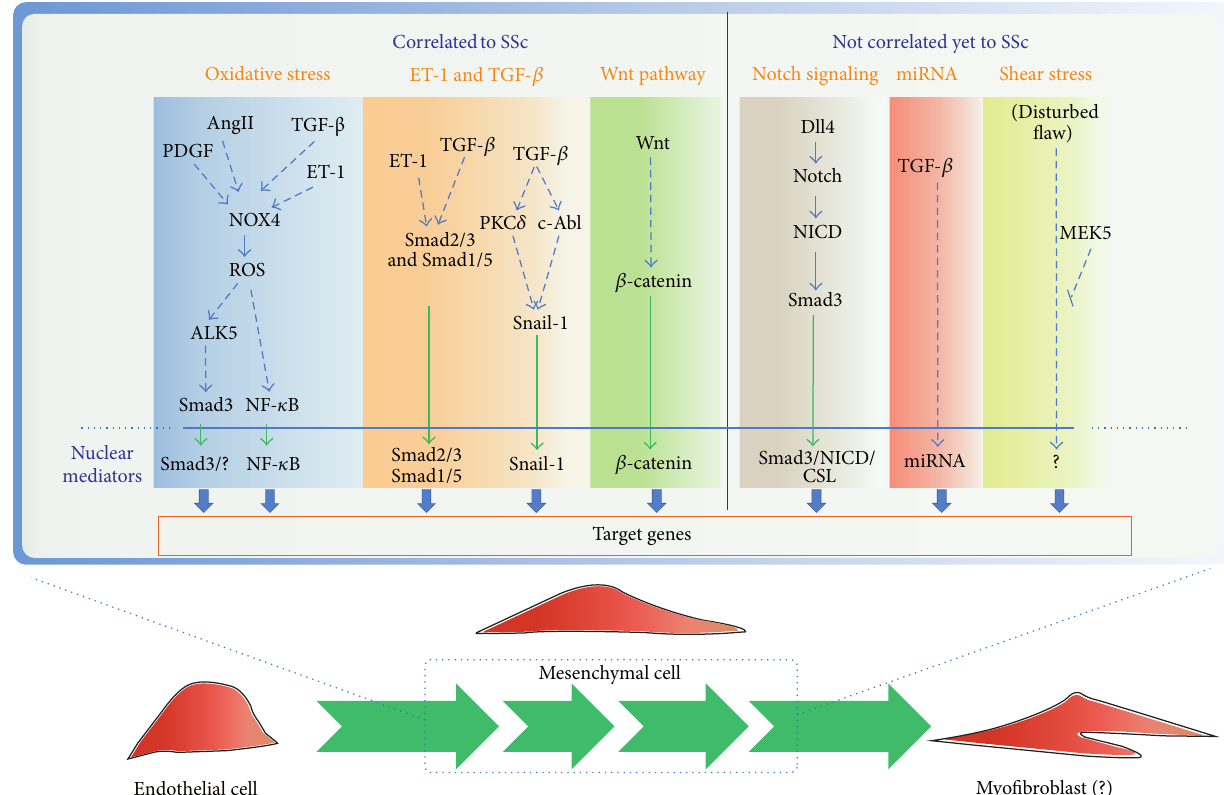
Figure 2: Pathways involved in the EndoMT. The scheme summarized the putative pathways involved in the EndoMT highlighting which are already correlated or not with SSc. The activation of specific nuclear mediator leads to activation of target genes that are correlated with the increase of mesenchymal markers (such as Col I, 𝛼 -SMA, and Twist 1) and/or decrease of endothelial markers (such as CD31, VE-Cad, and Fli-1). The activation of these pathways could lead endothelial cells to acquire initially mesenchymal characteristics and later on to acquire myofibroblastic